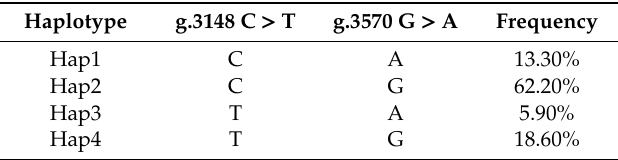
Table 3. Frequencies analysis of SIRT1 haplotypes.